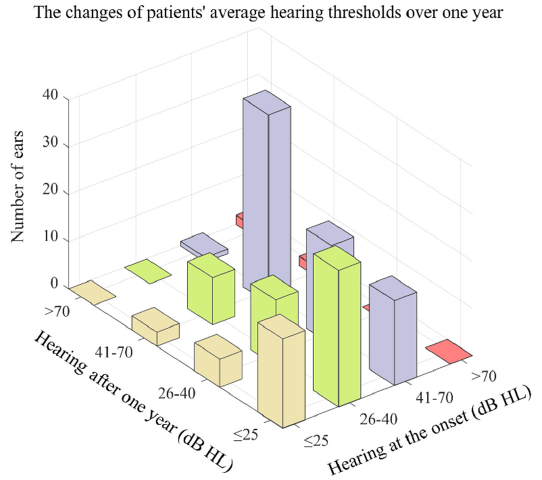
Figure 3. The changes in patients’ average hearing thresholds over one year.